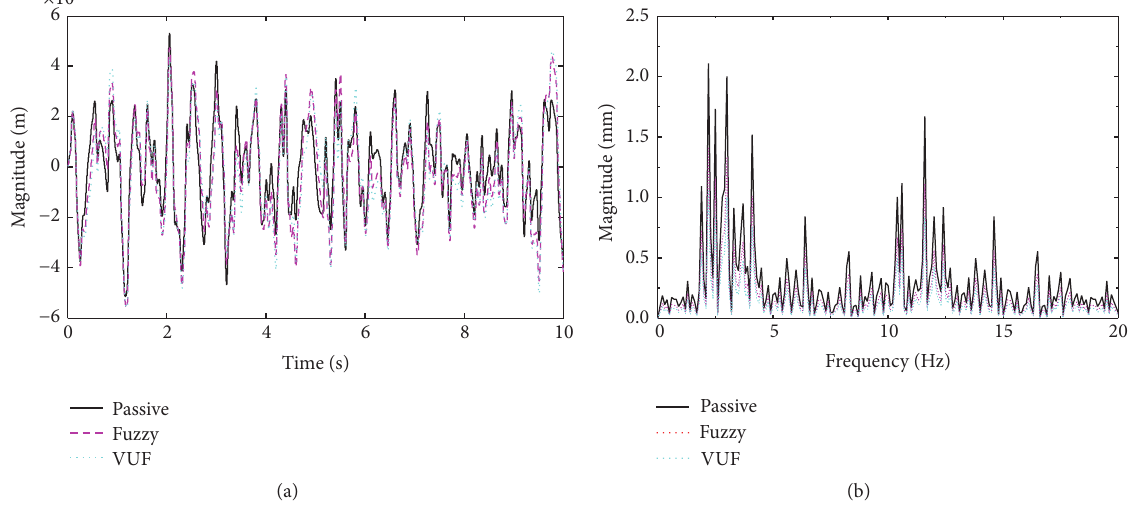
Figure 8: Suspension dynamic flexibility: (a) time domain and (b) frequency domain.